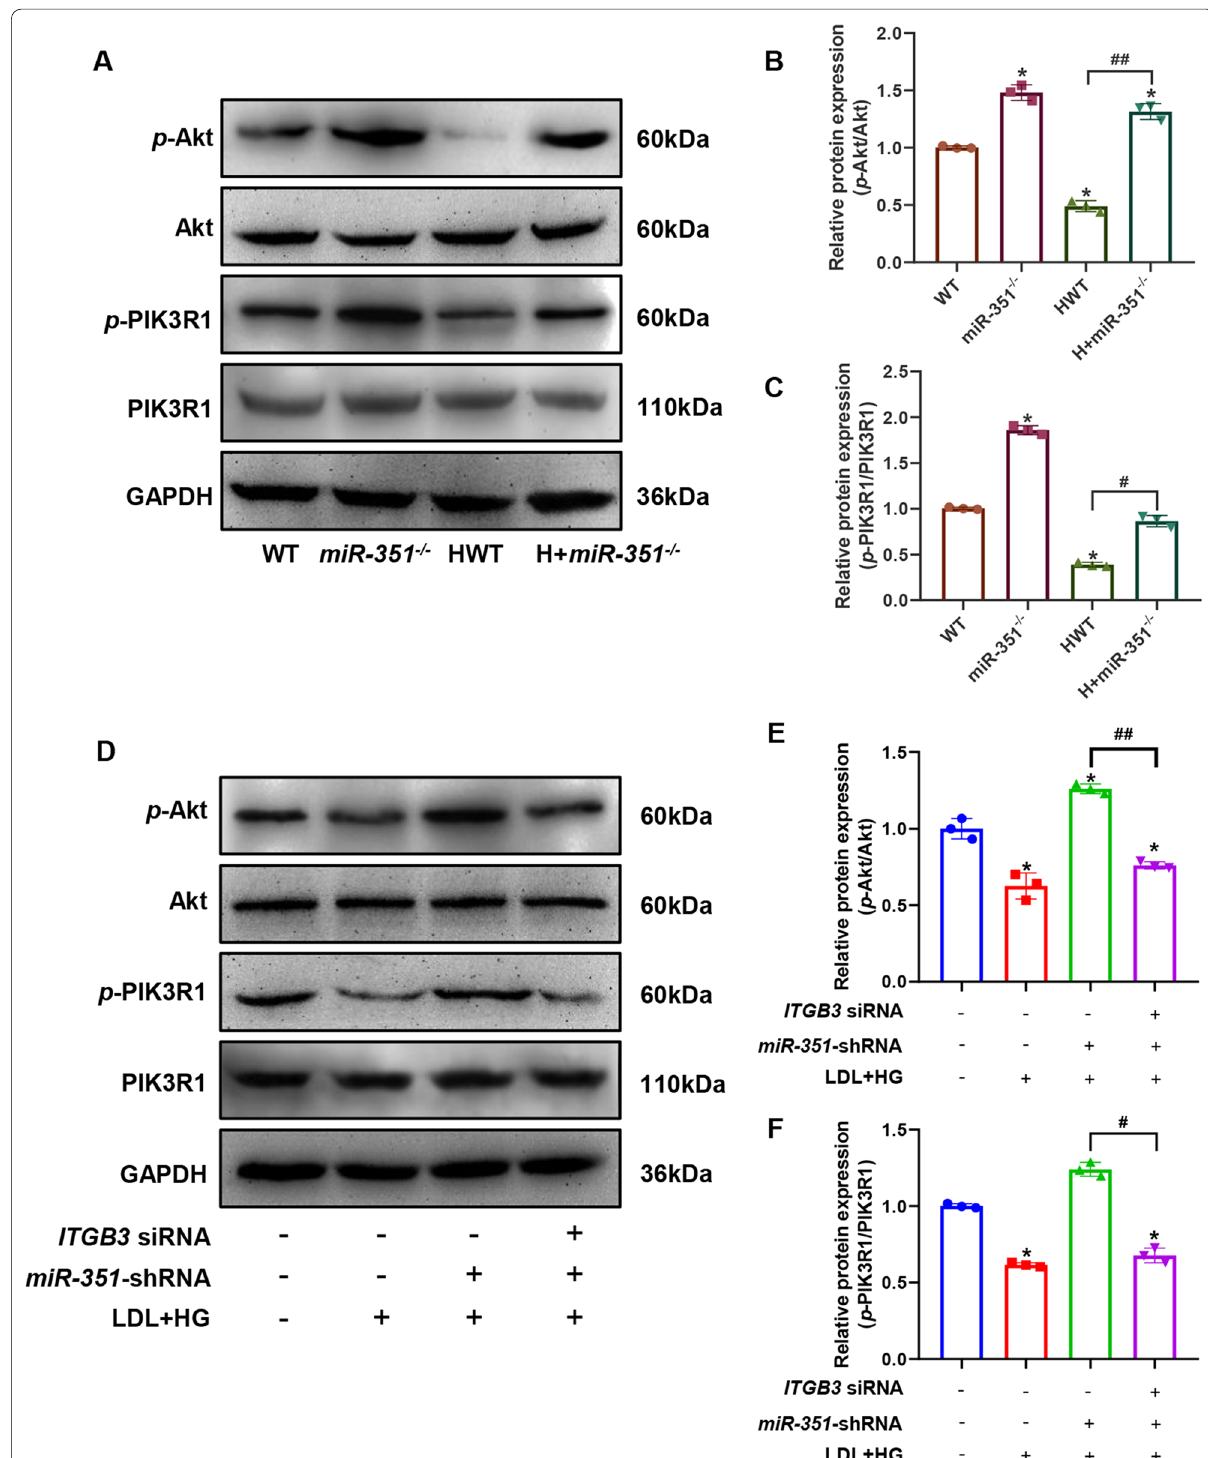
Fig. 10 Protein expression level of the PIK3R1/Akt pathway detected by western blotting. A Results of western blot detection of mouse aortic tissue. B , C The western blotting bands quantified in mouse tissues are presented as the ratios of p -Akt/Akt and p -PIK3R1/PIK3R1. D Cell western blot detection results. E , F Quantitative statistical results of cell western blotting bands shown as the ratios of p -Akt/Akt and p -PIK3R1/PIK3R1. **P < 0.01, *P < 0.05, vs. WT group or control group. ## P < 0.01, # P < 0.05, comparison between the two groups of connections. Animal and cell experiments, N 3 per =